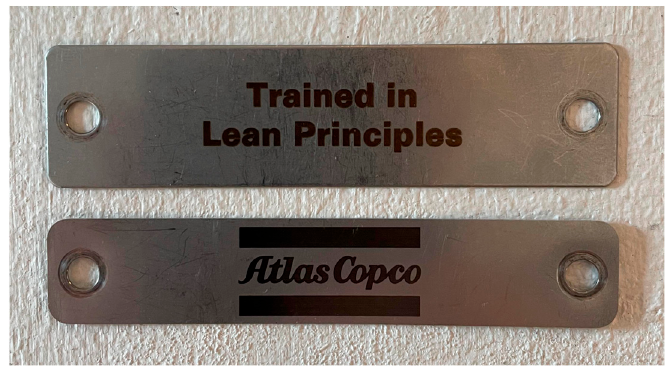
Figure 12. The labels assembled in step 6 (below) and step 7